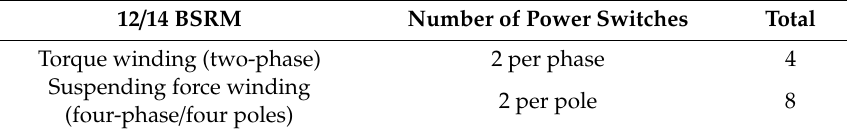
Table 3. Switching state rule of the hysteresis control method for the bearingless switched Table 2. Switch numbers for the 12 / 14 bearingless switched reluctance motor (BSRM). reluctance motor (BSRM).